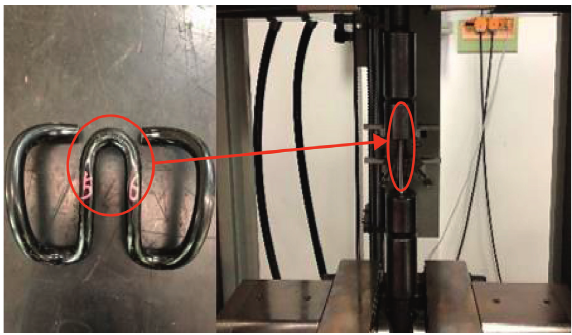
Figure 3: A tensile testing site for the clip material 38Si7. Figure 4: The Vossloh 300-1 fastener system (from the official website of Vossloh